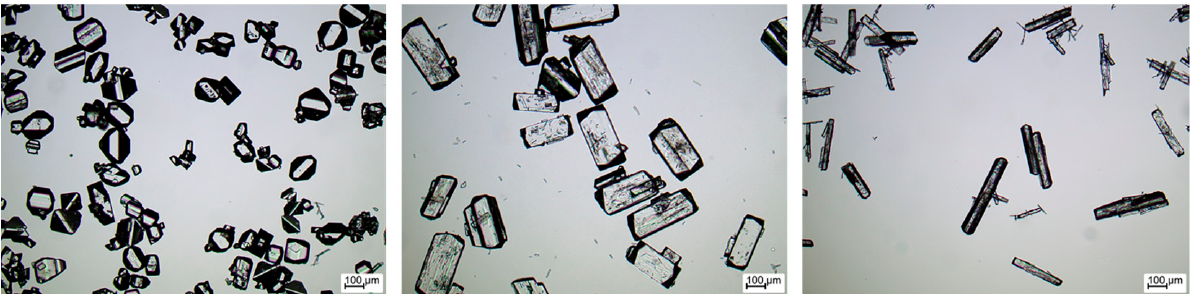
Figure 1. Microscopic images of the bipyramidal (spherical-like), cuboidal, and needle-like seed crystals of the material system L -alanine/water modified with L -glutamic acid of different concentrations in solution (higher concentration from ( left ) to ( right ) [37]).